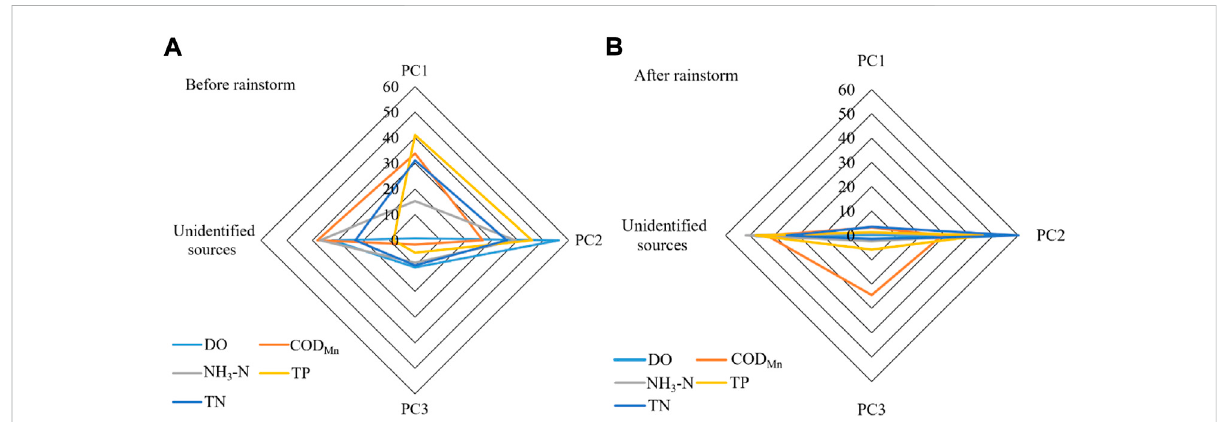
FIGURE 11 The contribution rates for water pollutants before rainstorm (A) and after rainstorm (B) . The absolute contribution rates of pollution sources (PC1, PC2, PC3, and unidenti fi ed pollution sources) to water pollutants were calculated based on absolute principal components-multiple linear regression